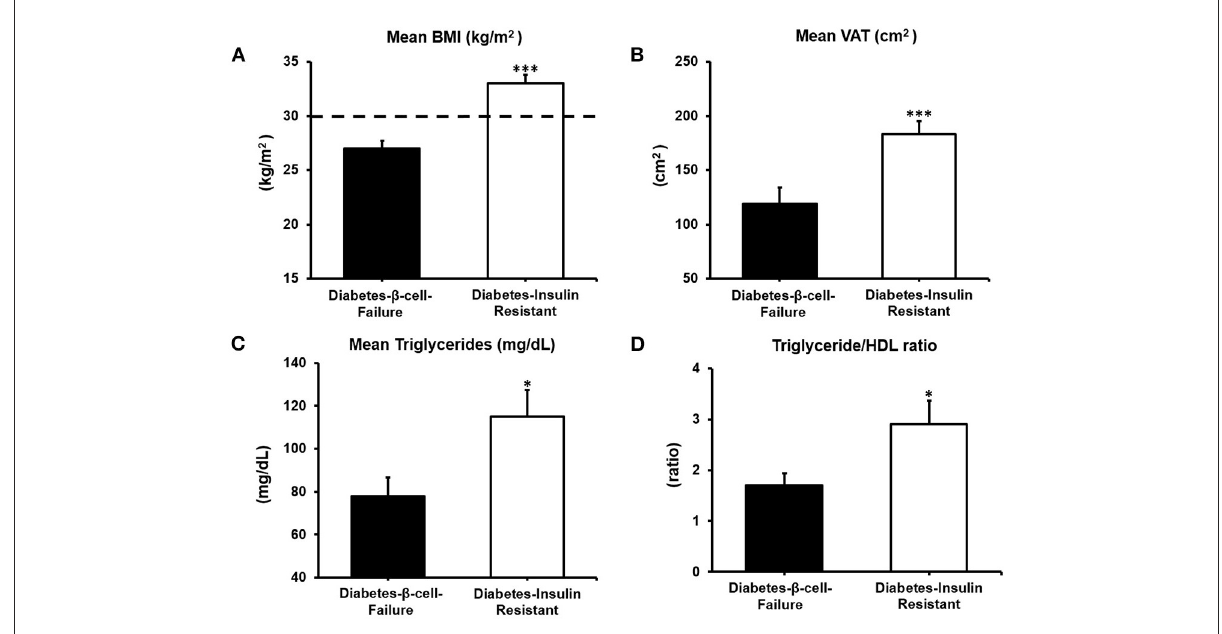
FIGURE2 Body composition and lipid parameters according to etiology of diabetes: (A) Body Mass Index (BMI). (B) Visceral Adipose Tissue (VAT). (C) Triglycerides and (D) Triglyceride/HDL ratio. *** P < 0.001; ** P < 0.01; * P < 0.05.